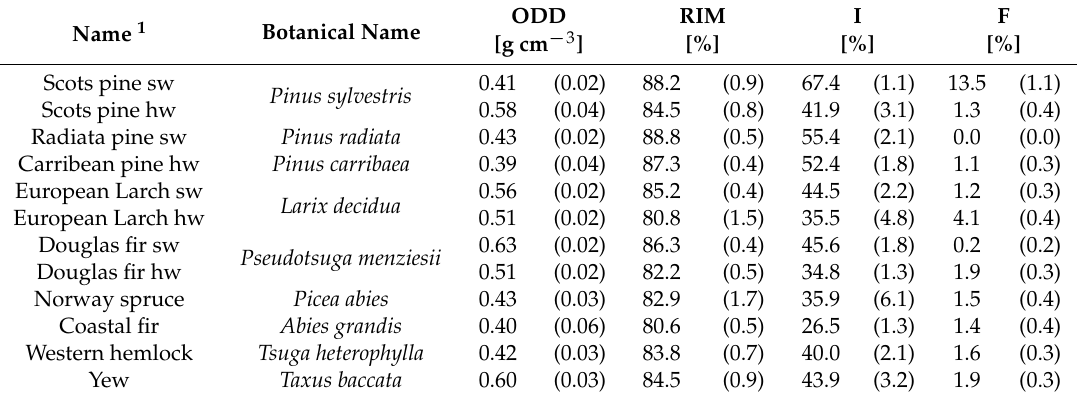
Table 1. The oven-dry density (ODD), Resistance to Impact Milling (RIM), degree of integrity (I), and fine percentage (F) of different softwood species. The standard deviation (SD) is in